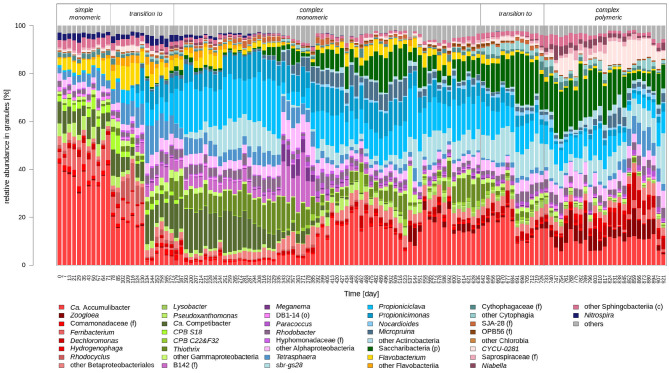
Evolution of the bacterial community composition during the transition from simple to complex monomeric wastewater and to complex polymeric wastewater. The genera are colored according to the class they belong to, with the exception of the Betaproteobacteriales, previously the class of Betaproteobacteria, colored in red. They were recently merged with the Gammaproteobacteria (Parks et al., 2018), here colored in light green. Only the abundant bacteria (mean > 1% with at least one wastewater type) are shown.